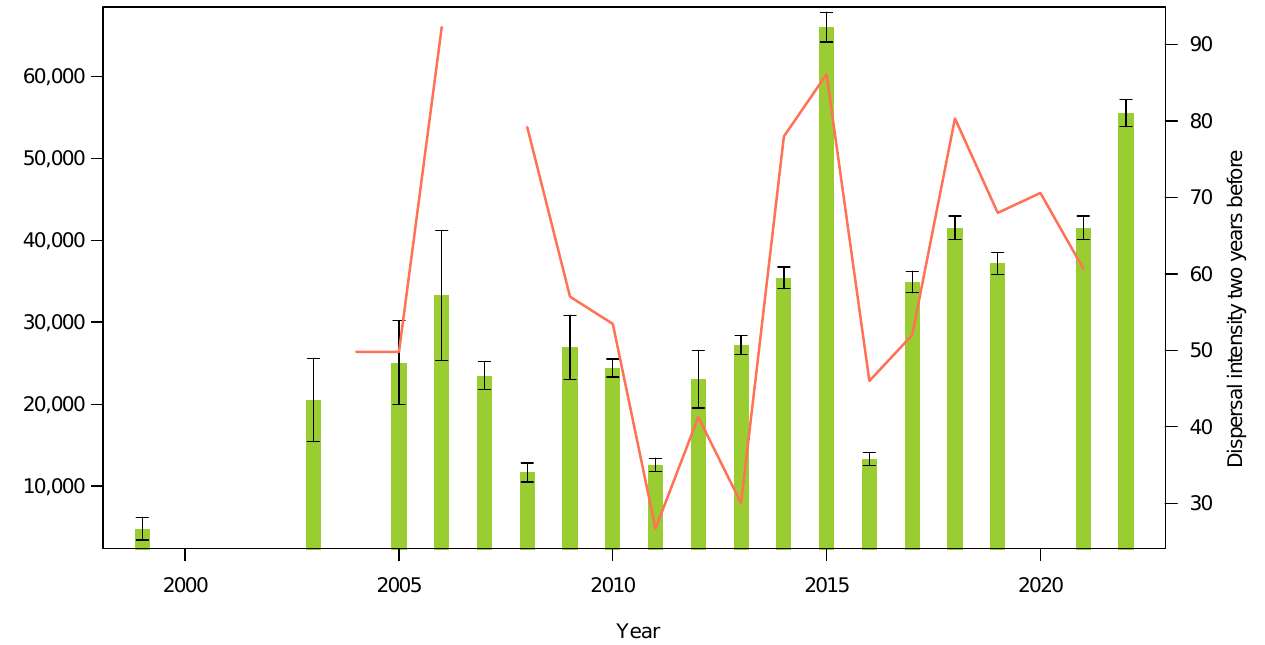
Figure 9. The relationship between dispersal intensity of the dead horse arum from two years previously (red lines, right y -axis), and plant density (green bars, left y -axis) (see more details in the text).